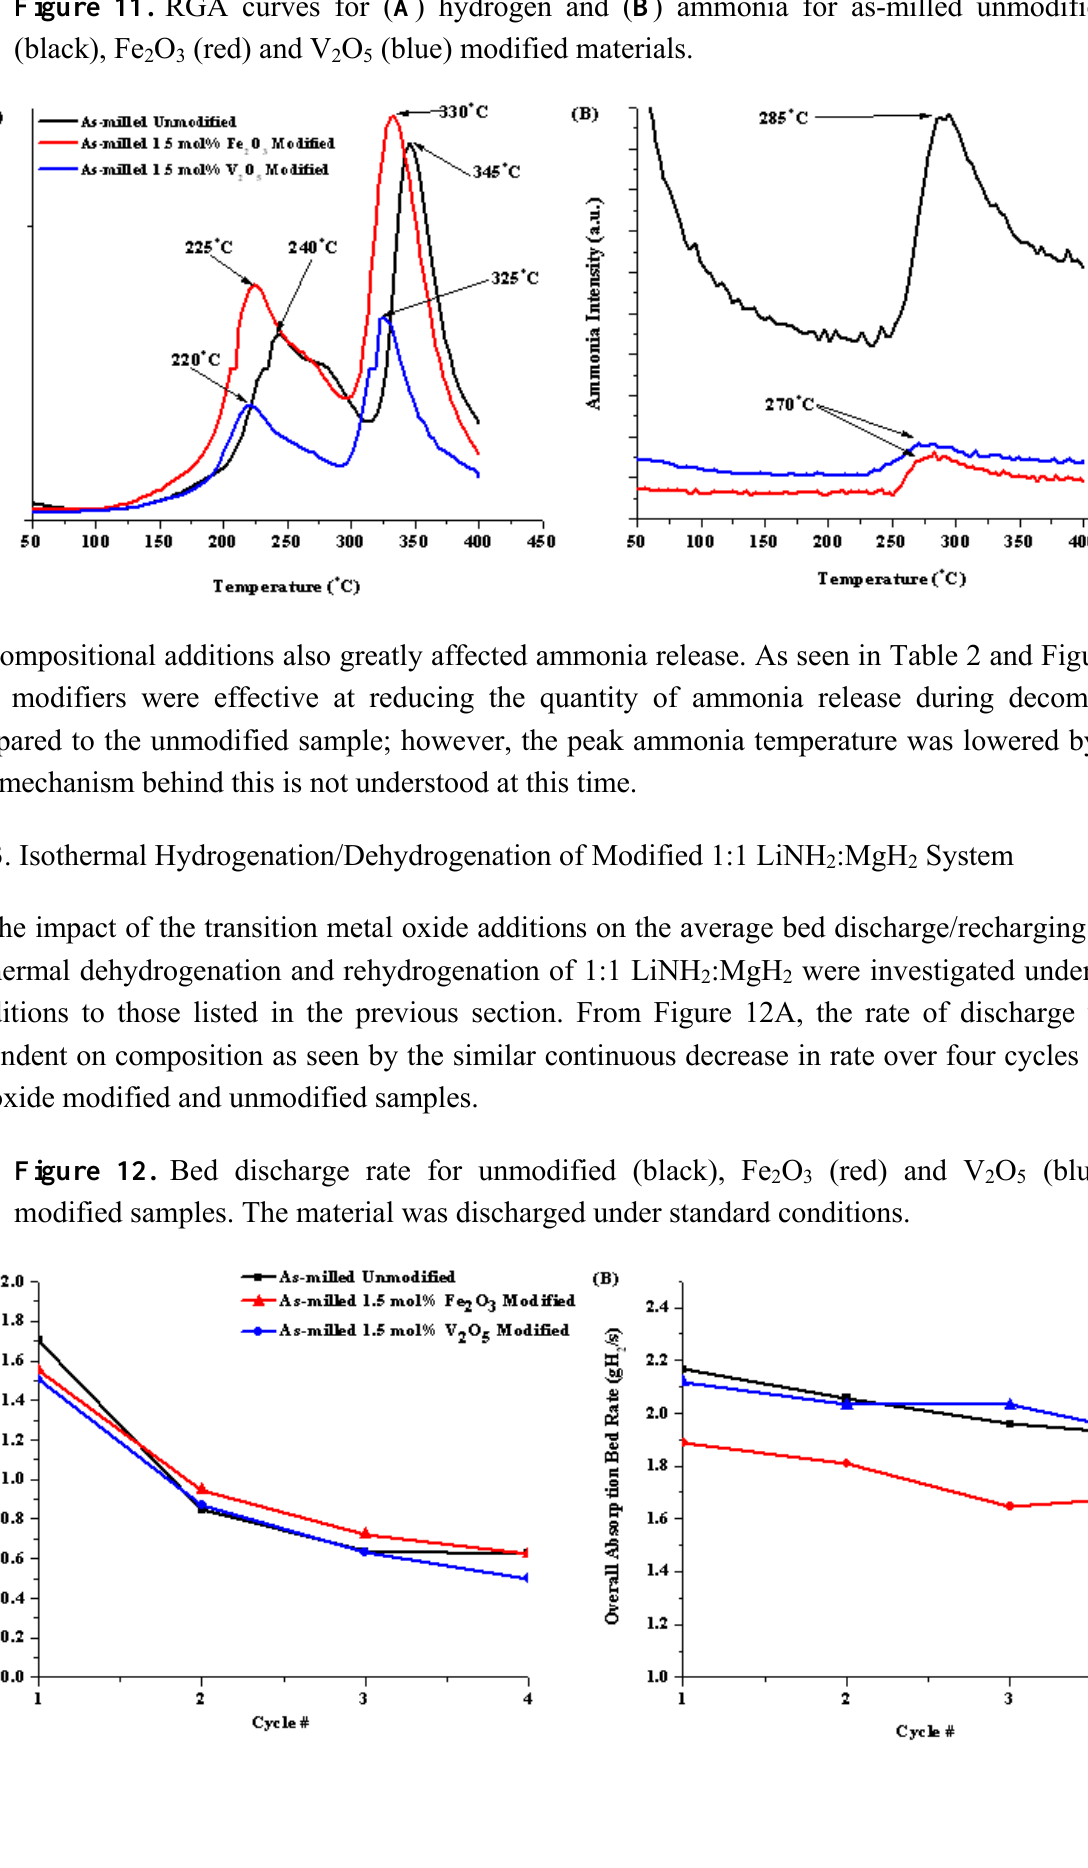
Figure 11. RGA curves for ( A ) hydrogen and ( B ) ammonia for as-milled unmodified O (red) and V O (blue) modified materials. (black), Fe 2 3 2 5